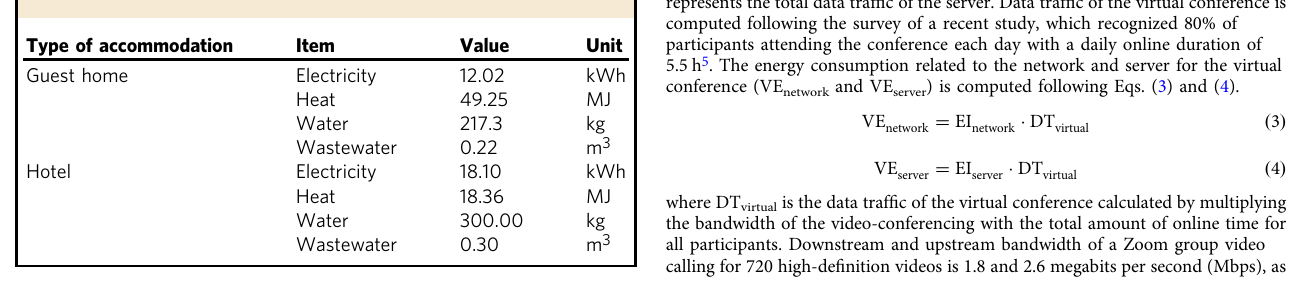
Table 2 Energy and water consumption of accommodation per capita per day by the type of accommodation 45 – 47,64,65